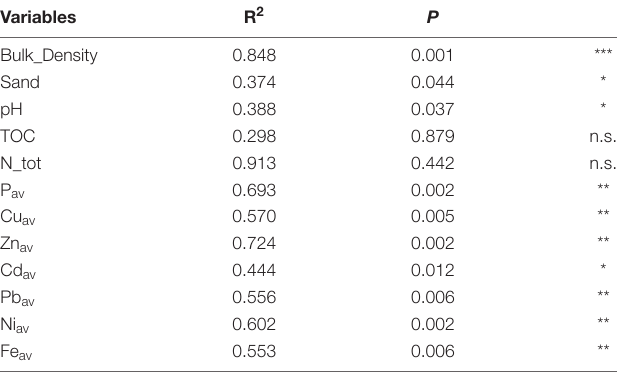
TABLE 4 | Envfit function output showing the variables significantly correlated with the NMDS ordination.